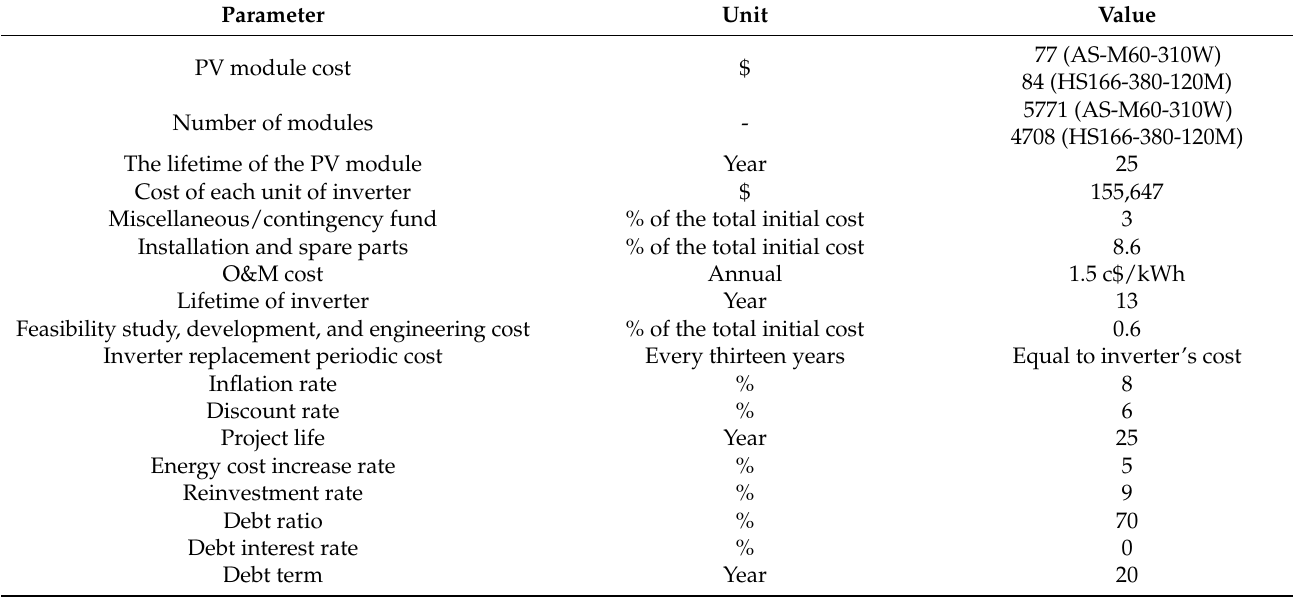
Figure 9. Monthly average electric production for some selected orientation angles. Table 6. Economic and financial parameters used for